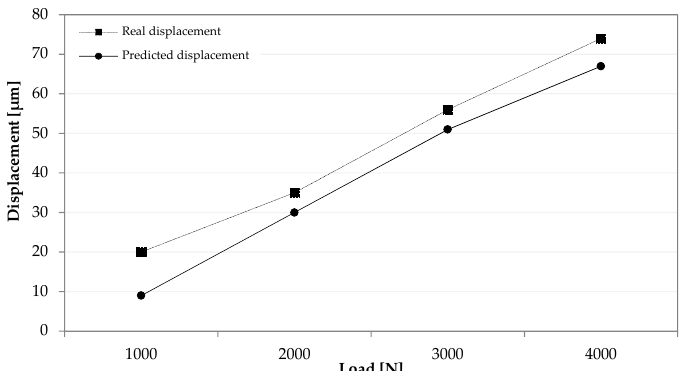
Figure 7. The static force effects: a comparison between the real tool tip displacement and the predicted position when a static force is applied to the tool tip point.